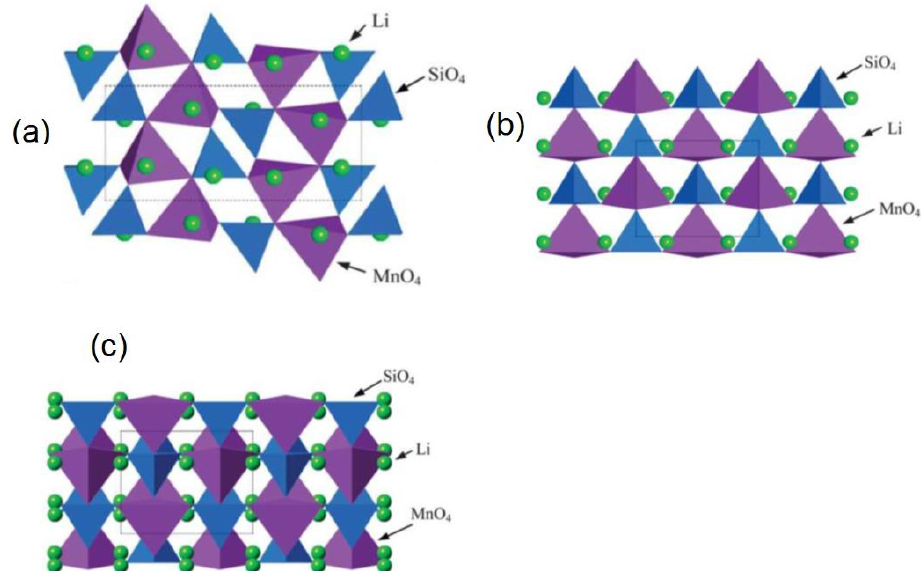
Figure 7. Crystal structures of Li 2 MnSiO 4 polymorphs: ( a ) monoclinic P21/n phase, ( b ) orthorhombic Pmn21 phase, ( c ) orthorhombic Pmnb phase, revealing the arrangement of MnO 4 tetrahedra (purple), SiO 4 tetrahedra (blue) with Li-ions (green). Reproduced from [76] with permission from the Royal Society of Chemistry.